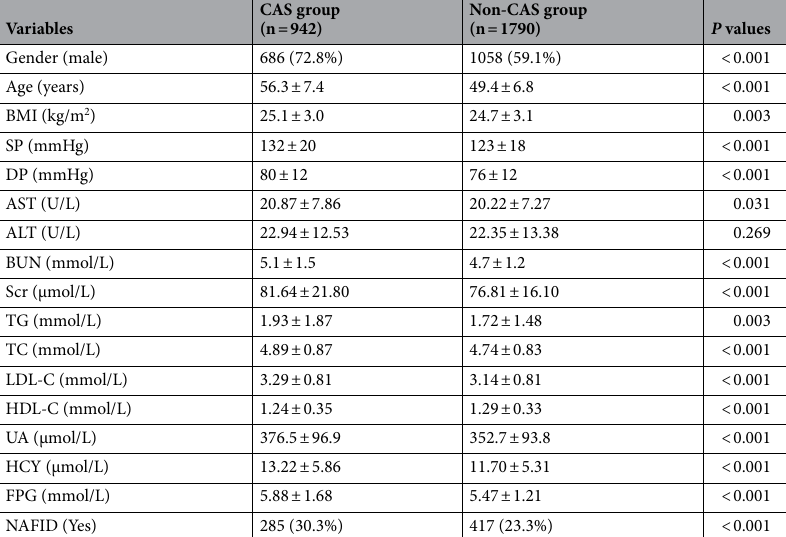
Table 1. Subjects characteristics in CAS group and non-CAS group. CAS, carotid atherosclerosis; BMI, body mass index; SP, systolic blood pressure; DP, diastolic blood pressure; AST, serum aspartate aminotransferase; ALT, serum alanine aminotransferase; BUN, blood urea nitrogen; Scr, serum creatinine; TG, triglyceride; TC, total cholesterol; LDL-C, low-density lipoprotein cholesterol; HDL-C, high-density lipoprotein cholesterol; UA, blood uric acid; HCY, homocysteine; FPG, fasting plasma glucose; NAFLD, nonalcoholic fatty liver